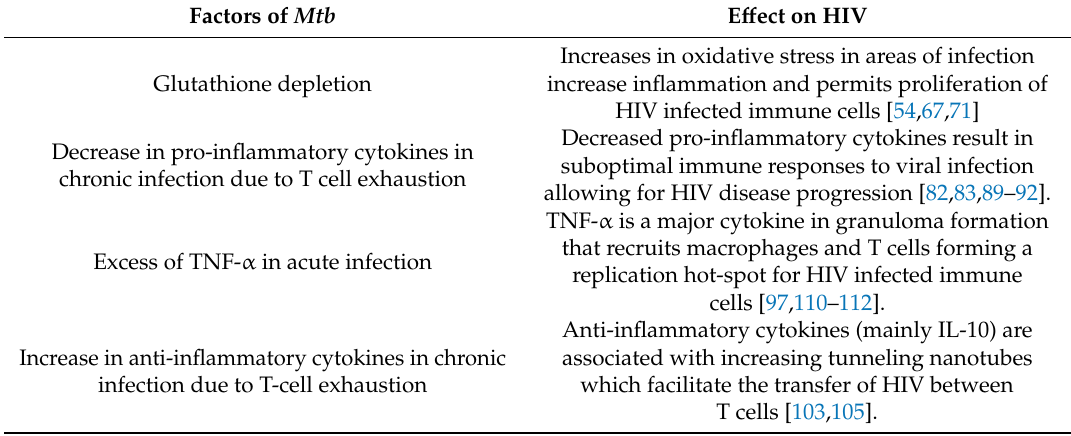
Table 1. Summary of Mtb factors that can exacerbate HIV